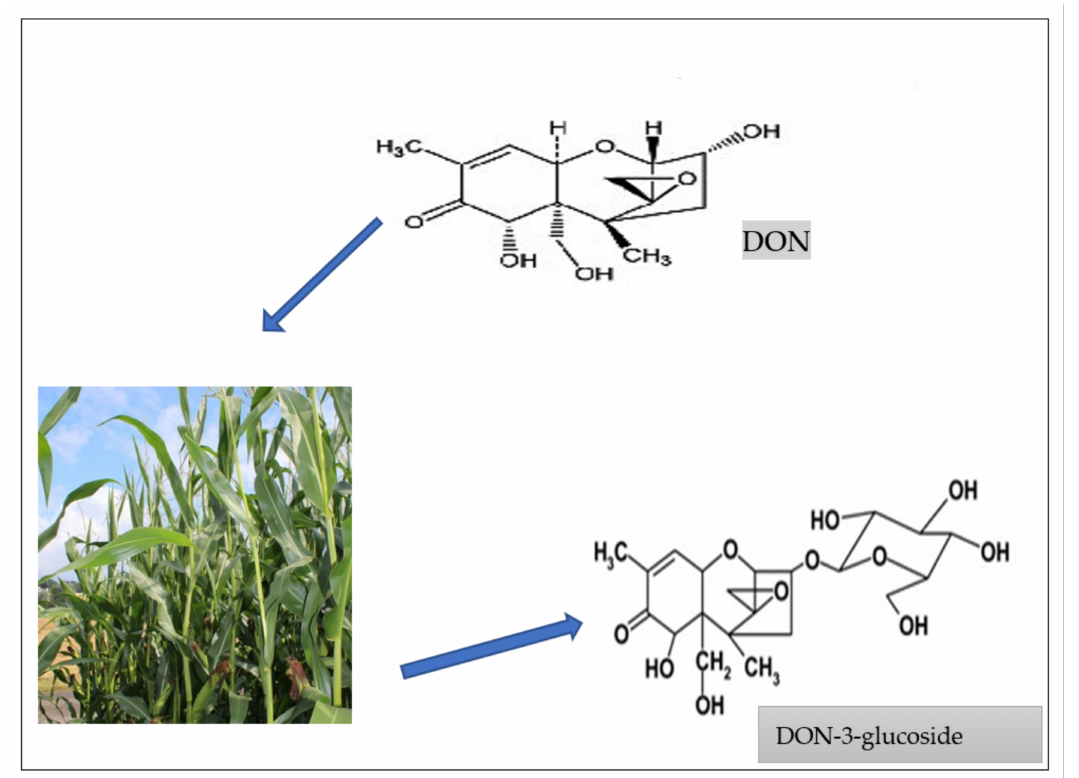
Figure 4. How plants metabolize free mycotoxins to form masked mycotoxins, e.g., DON forms DON-3-glucoside